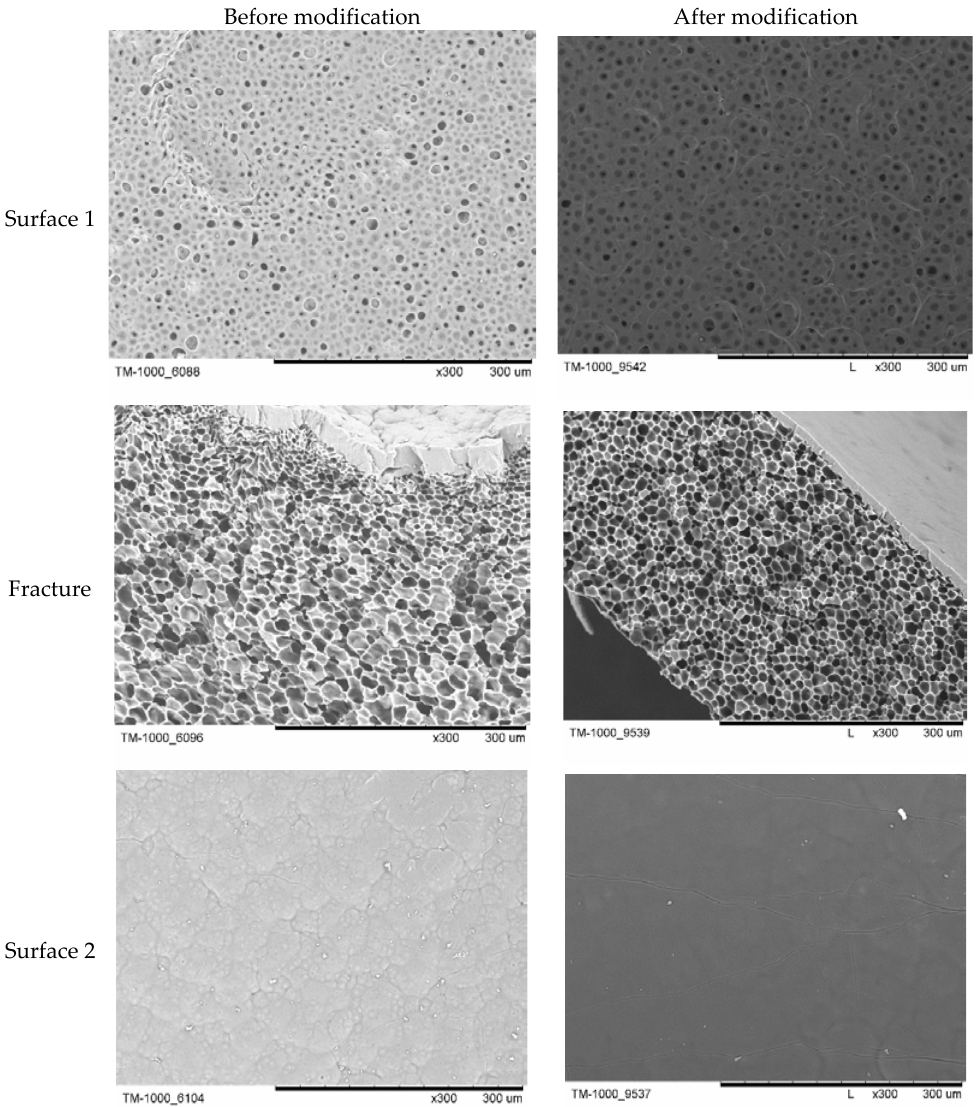
Figure 7. The morphology of Membrane II (MII) before and after plasma modification.